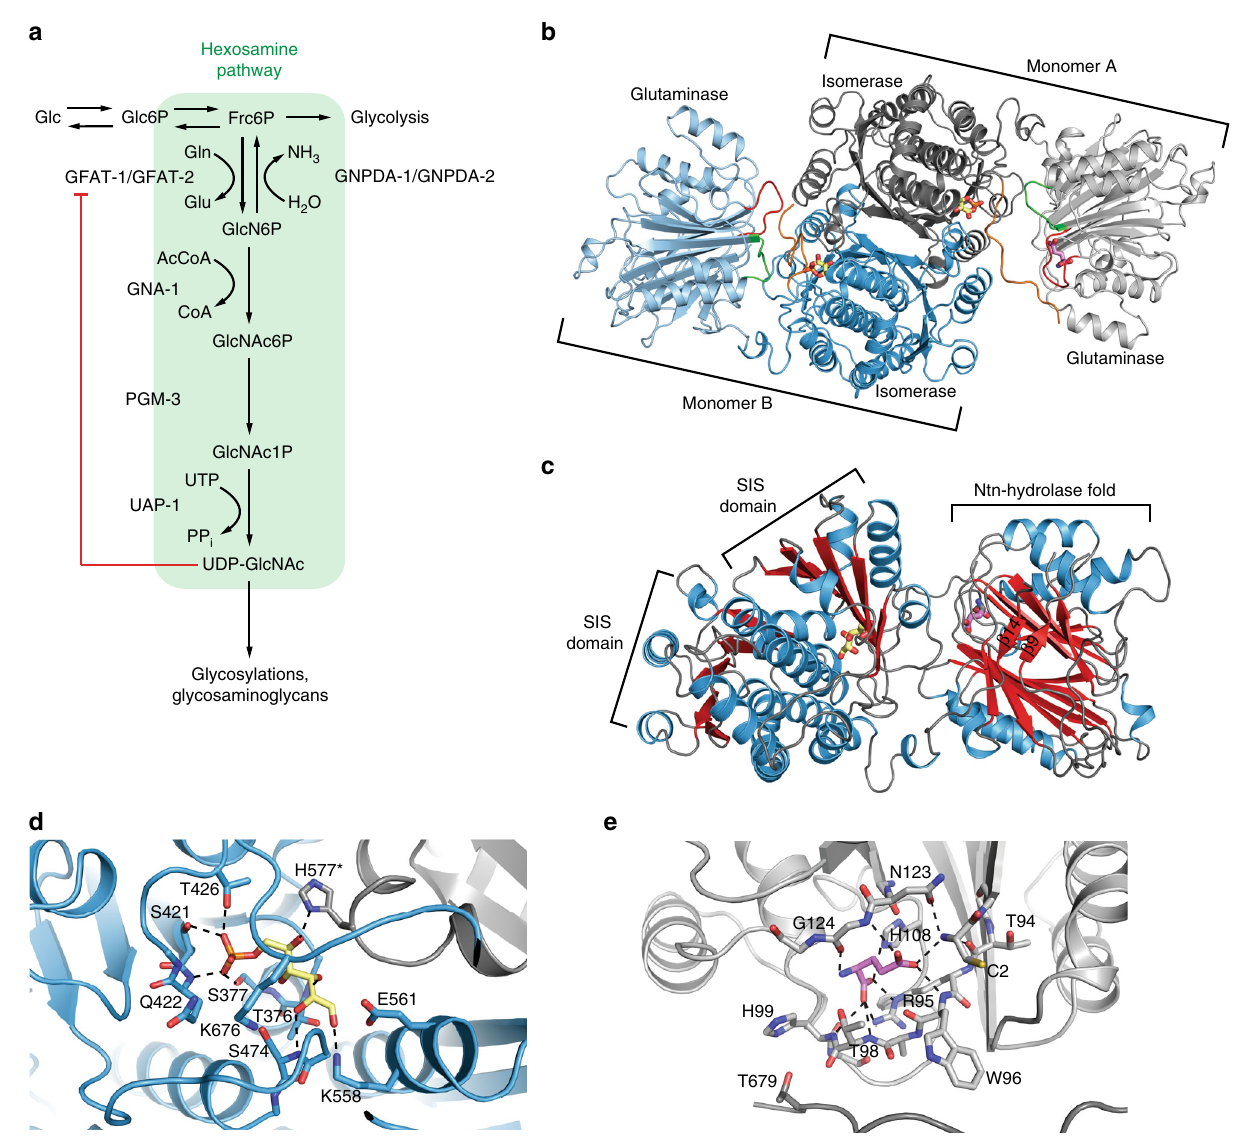
Fig. 1 Structure of human GFAT-1, the key enzyme of the hexosamine pathway. a Schematic representation of the hexosamine pathway (green box). The enzymes in the pathway are glutamine fructose-6-phosphate amidotransferase (GFAT-1/-2), glucosamine-6-phosphate N -acetyltransferase (GNA-1), phosphoglucomutase (PGM-3), UDP- N -acetylglucosamine pyrophosphorylase (UAP-1), and glucosamine-6-phosphate deaminase (GNPDA-1/ − 2). UDP- GlcNAc inhibits eukaryotic GFAT (red line). b Overall structure of the human GFAT-1 dimer in cartoon representation. The N-terminal glutaminase domains are colored in light blue and light gray, and the C-terminal isomerase domains in marine and dark gray. Glc6P (yellow sticks) and L -Glu (violet sticks) are highlighted, as well as important loops discussed in this manuscript: R-loop (green), Q-loop (red), and C-loop (orange). c Secondary structure elements of human GFAT-1. β -Sheets are colored in red and α -helices in blue. Glc6P (yellow sticks) and L-Glu (violet sticks) are highlighted. The isomerase domain (left) consists of two sugar isomerase (SIS) sub-domains. The glutaminase domain (right) is composed of a Ntn-hydrolase fold ( αββα -core) with two short antiparallel β -sheets covering one side ( β 9 and β 14). d , e Active sites of human GFAT-1. The protein is in cartoon representation; residues involved in substrate binding or catalysis are highlighted as sticks, and dashed lines indicate key interactions. d Frc6P-binding site formed by both isomerase domains. e L -Gln-binding site in one glutaminase